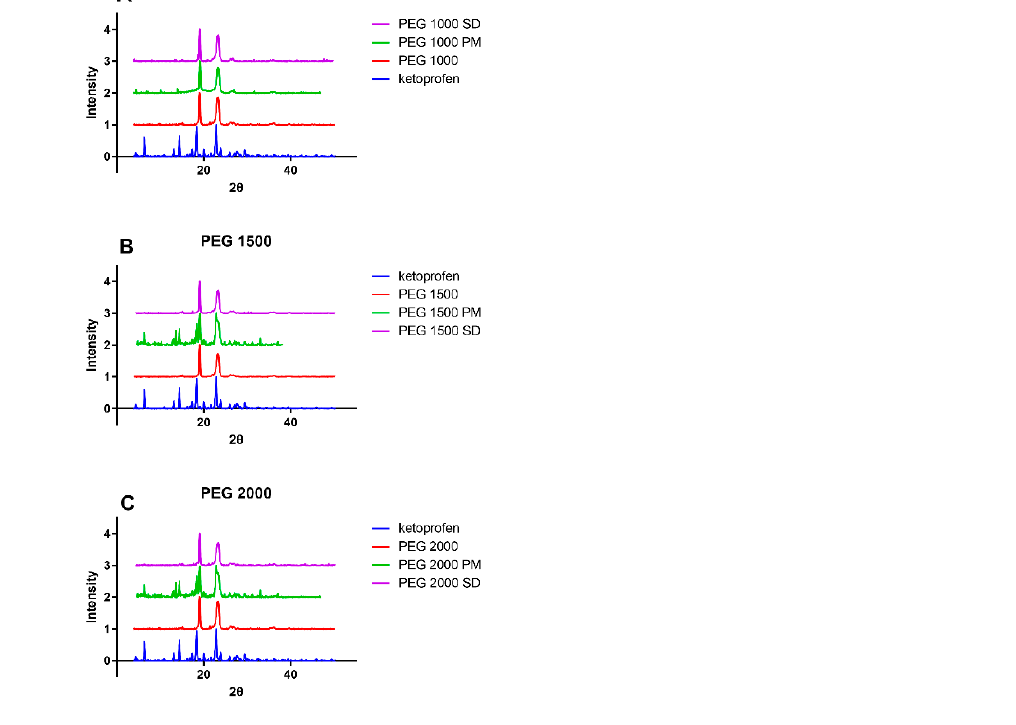
Figure 3. PXRD spectra of ketoprofen, pure PEGs, physical mixtures (PM), solid dispersions (SD) for PEG 1000 ( A ), PEG 1500 ( B ), and PEG 2000 ( C ).